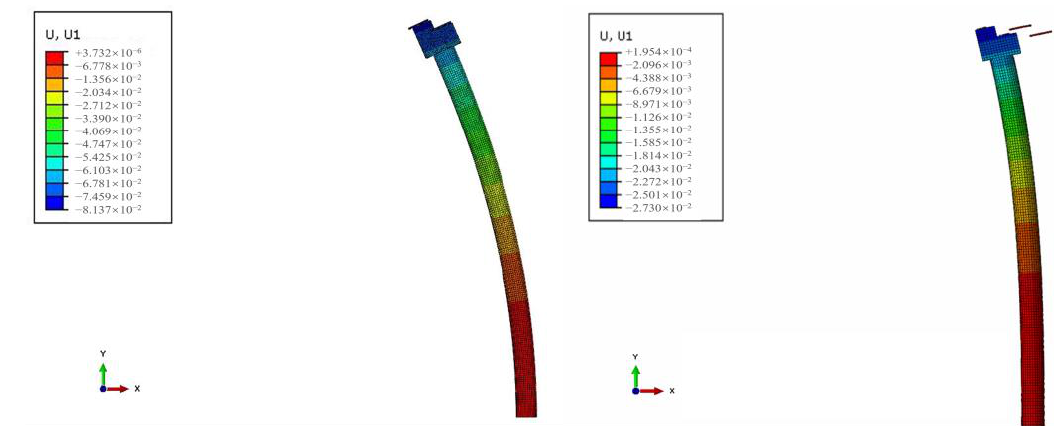
Figure 17. Deformation of Pier P30.